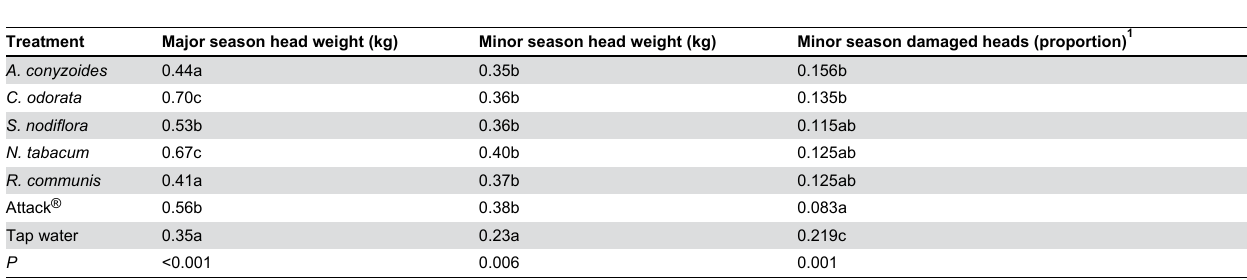
Table 1. Effect of plant extracts and synthetic insecticides on cabbage head weight and Lepidoptera damage in field experiments at Kumasi,